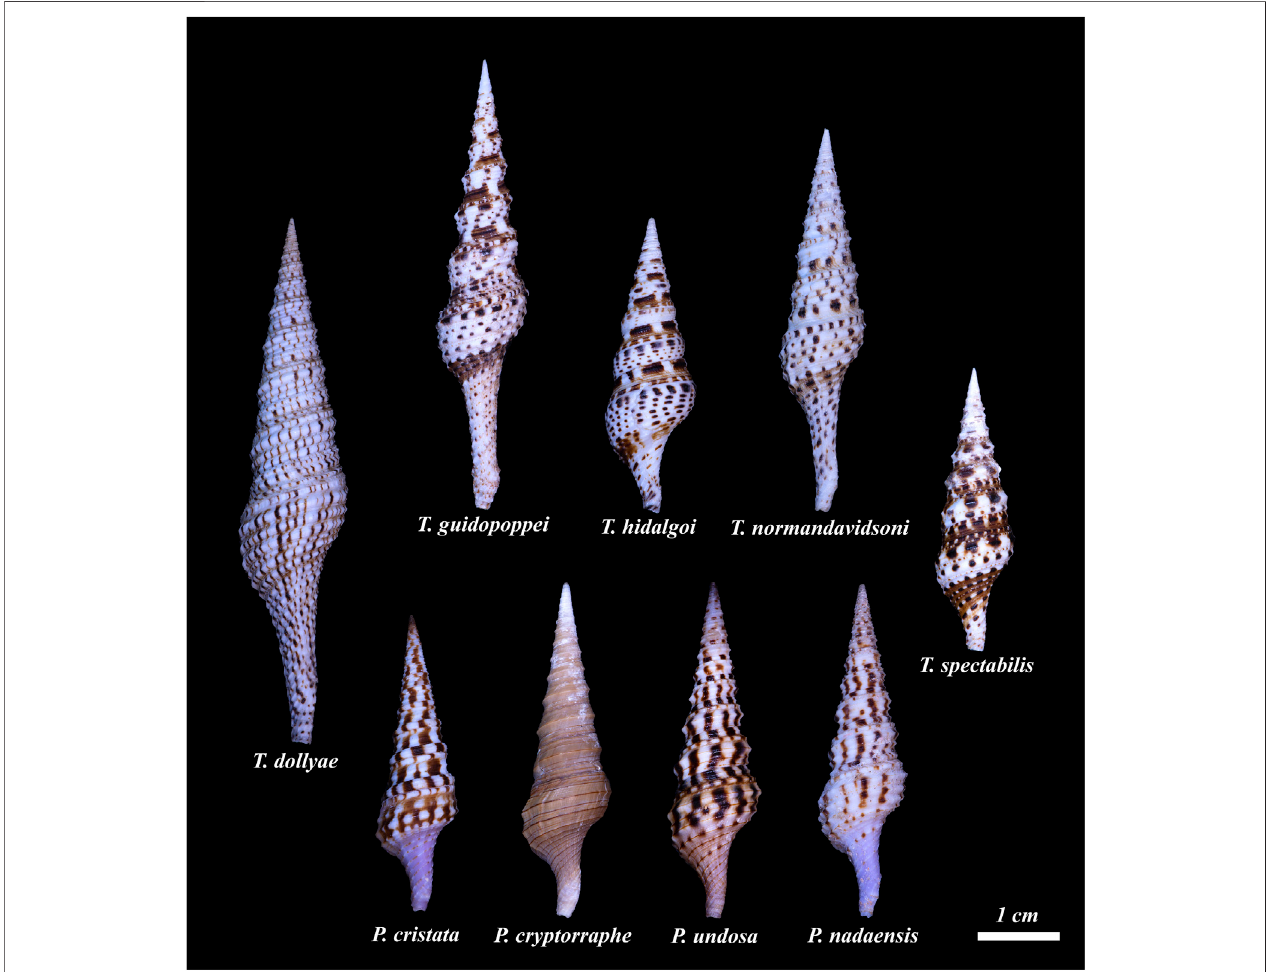
FIGURE1| Theninespecies conventionallyassignedtothegenus Turris forwhichavenom glandtranscriptomeisavailable areshown.Toprowlefttoright: Turris dollyae , Turrisguidopoppei , Turrishidalgoi , Turrisnormandavidsoni , Turrisspectabilis .Thespeciesshownonthelowerrowwereassignedtothegenus Turris ,butaswill be demonstratedthrough thedata obtained inthiswork,they belong toanew genus, Purpuraturris .From lefttoright: Purpuraturris cristata ; Purpuraturris cryptorraphe ; Purpuraturris undosa ; Purpuraturris nadaensis . The shells were photographed individually and the photographs were cropped to maintain the size of the shells relative to each other. The scale bar represents an approximate length of 1 cm (Photographed by Samuel Espino.)